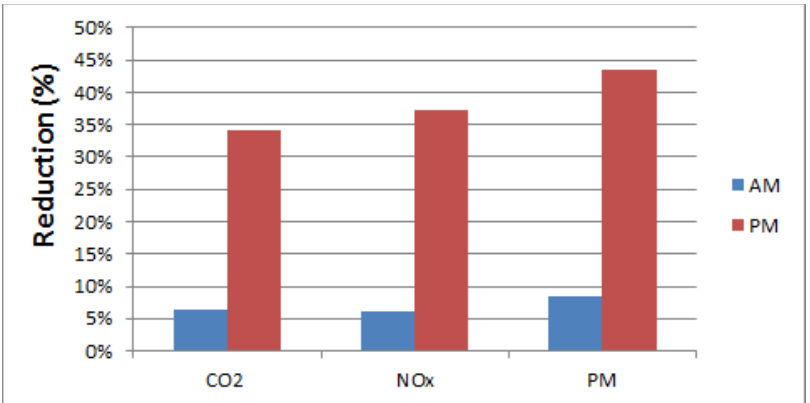
Figure 10. Impact of implementation of fixed-time signal control strategy at pedestrian